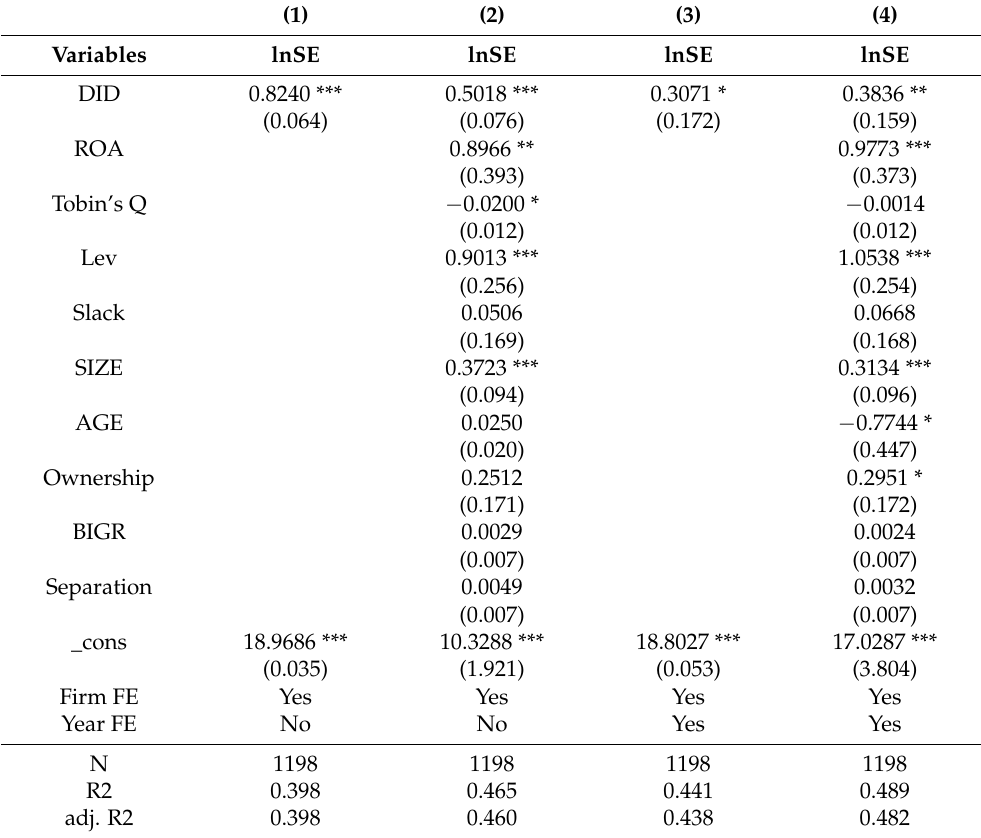
Table 3. The Impact of Two-Invoice System on Selling